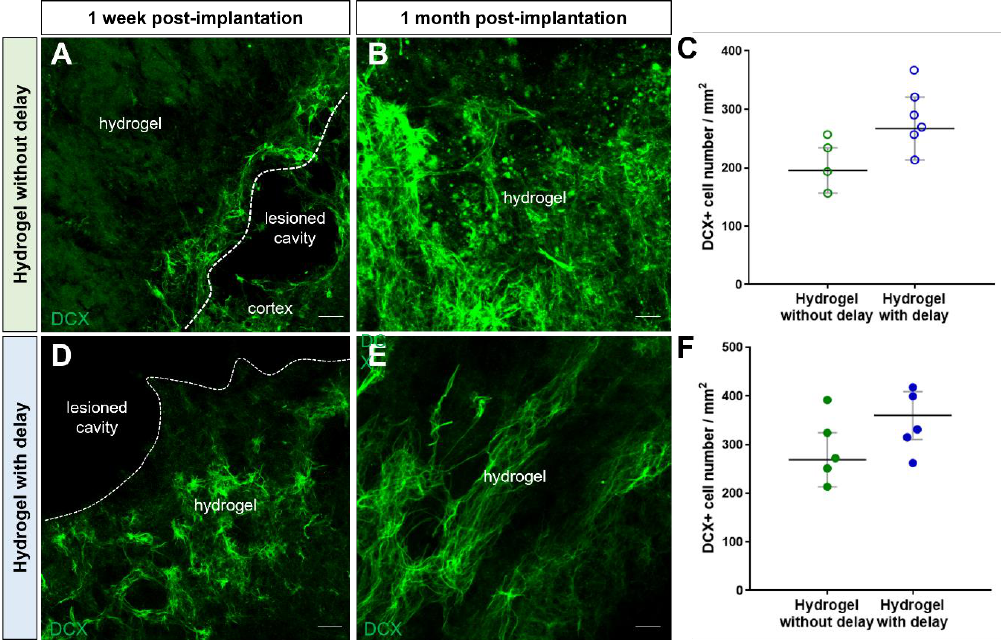
Figure 5. Neuroblasts migration into hydrogel. ( A – C ) Representative immunofluorescence staining of neuroblasts labeled with DCX (green) in delay ( A , B ) or no-delay implanted groups ( C , D ). Dashed lines indicate hydrogel localization. The squares indicate the area of magnification. Scale bar: 20 μm. ( E , F ) Quantitative analysis of the neuroblast number, one week ( E ) or one month ( F ) after implantation, in implanted no-delay (green) or delay implanted groups (blue). Mann – Whitney test.